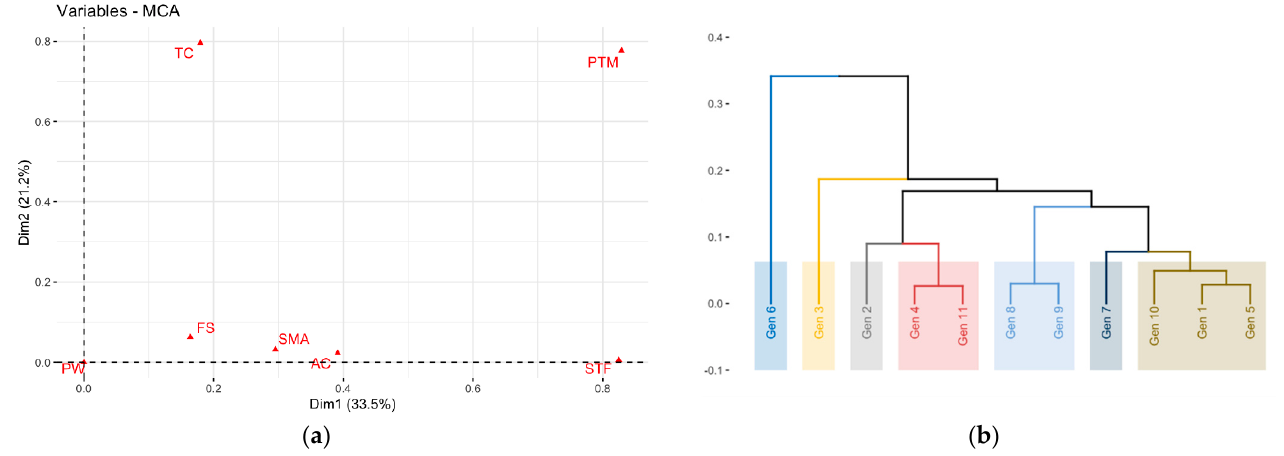
Figure 3. ( a ) Multiple correspondence analysis shows the contribution of qualitative variables. ( b ) Cluster analysis showing seven groups of yellow pitahaya materials formed according to qualitative variables.